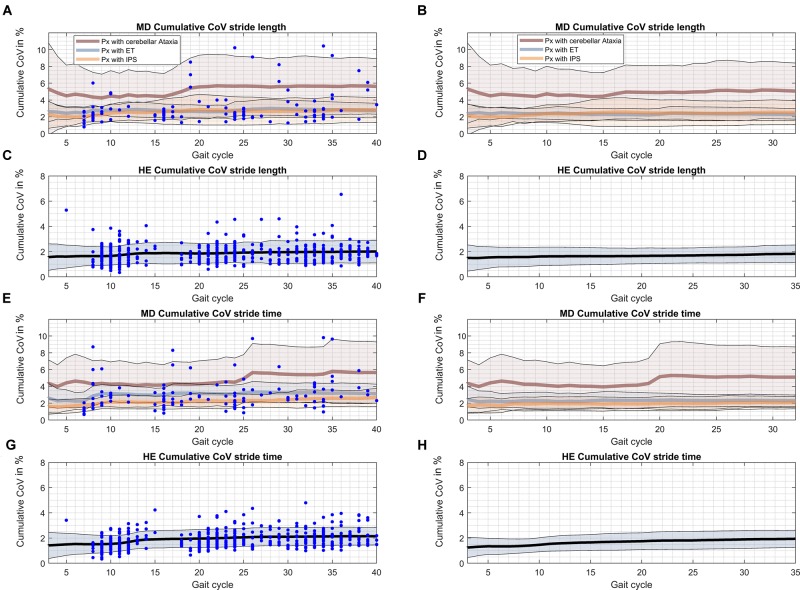
Cumulative CoVs for every gait cycle over the gait course. The occurrence of turns during the gait course is indicated by blue dots. Black – cumulative CoV of HE; brown – cumulative CoV of ATX; blue – cumulative CoV of ET; orange – cumulative CoV of PD. (A) Cumulative CoV stride length of patients with ataxia, essential tremor and Parkinson’s disease. (B) Cumulative CoV stride length of patients with ataxia, essential tremor and Parkinson’s disease after alternative turn segmentation. (C) Cumulative CoV stride length of healthy elderly. (D) Cumulative CoV stride length of healthy elderly after alternative turn segmentation. (E) Cumulative CoV stride time of patients with ataxia, essential tremor and Parkinson’s disease. (F) Cumulative CoV stride time of patients with ataxia, essential tremor and Parkinson’s disease after alternative turn segmentation. (G) Cumulative CoV stride time of healthy elderly. (H) Cumulative CoV stride time of healthy elderly after alternative turn segmentation.